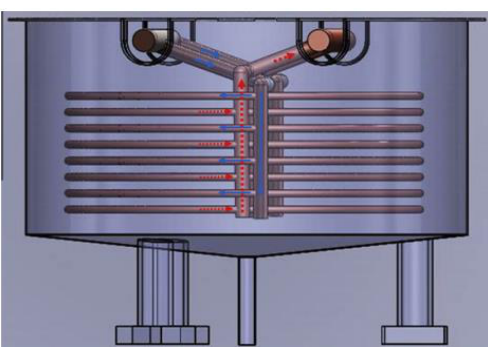
Figure 4 Front view of the tank [18]